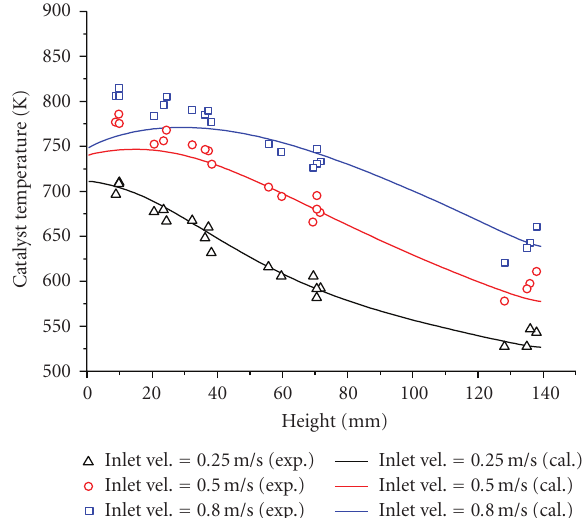
Figure 16: Catalyst temperature, model prediction versus experi- ment.